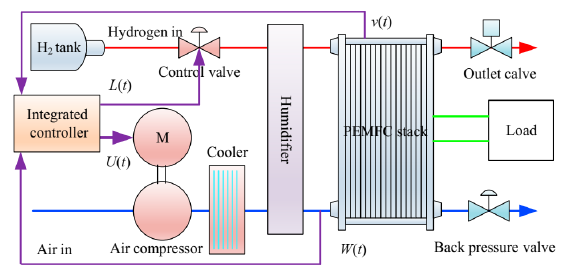
Figure 2. The control framework of integrated